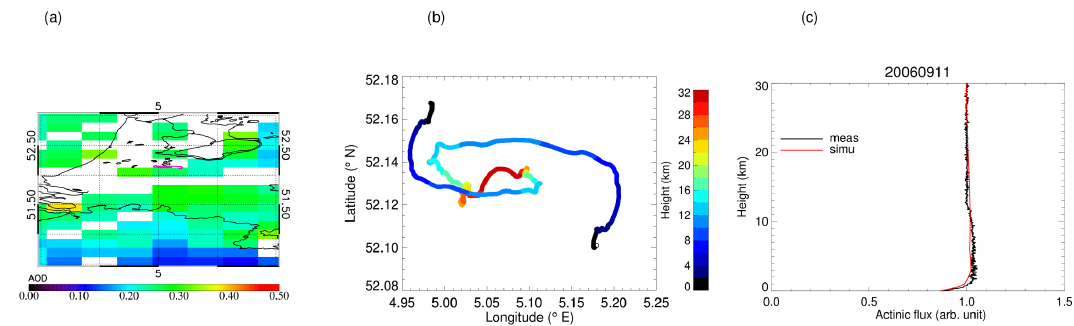
Figure 7. Clear-sky case on 11 September 2006. (a) MODIS aerosol optical thickness image at 11:45UTC; the purple curve shows the trajectory of the balloon. (b) Trajectory of the balloon, with its height indicated by colour. The location of De Bilt is marked with a circle. (c) Measured actinic flux profile and simulated actinic flux